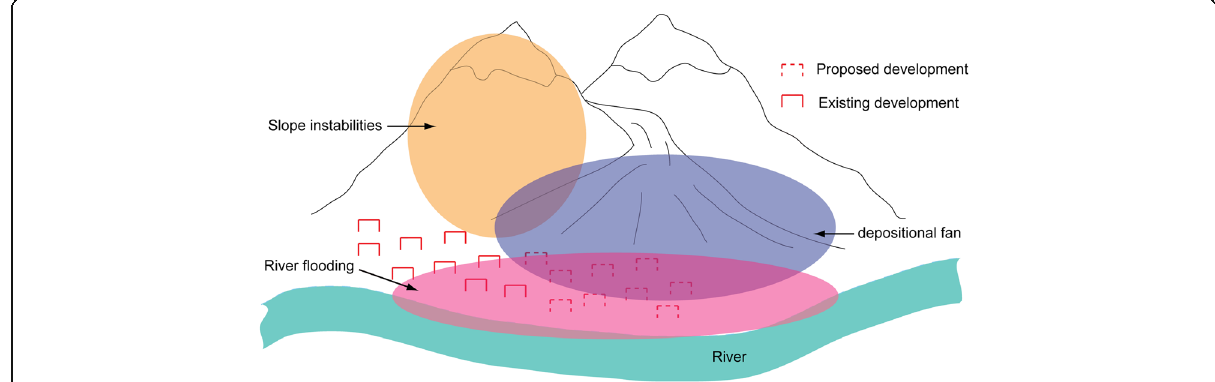
Fig. 3 Schematic illustration of existing and proposed residential areas in mountainous terrain highlighting some potential ground